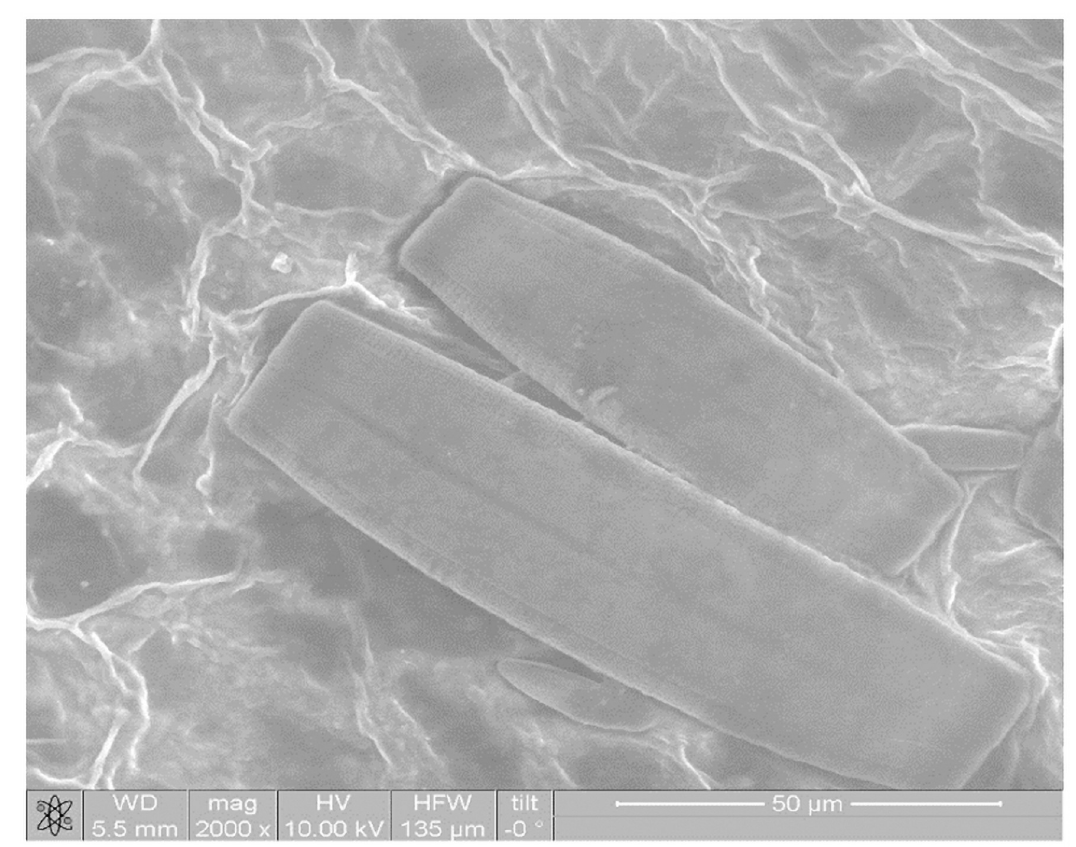
Fig 7. Microstructural of duckweed leaves Lemna minor with the combined influence of a magnetic field and an electric field in the CuSO 4